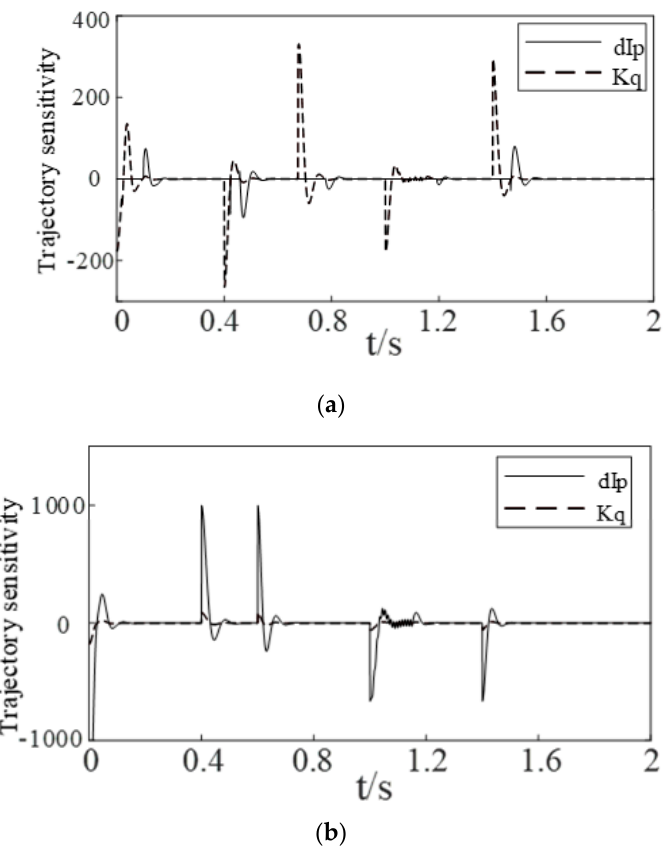
Figure 5. Sensitivity curve of the parameter to be identified: ( a ) sensitivity curve of active power of the parameter to be identified; ( b ) sensitivity curve of reactive power of the parameter to be identified.